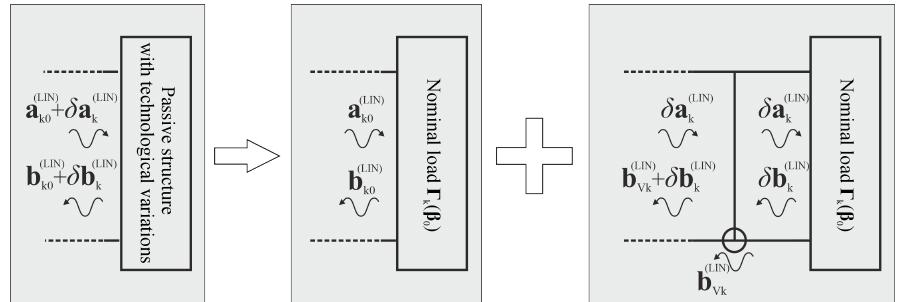
Figure 8. Port representation of the effect of technological variability in the passive block: the technology spread acts as an impressed generator b Vk proportional to the sensitivity S